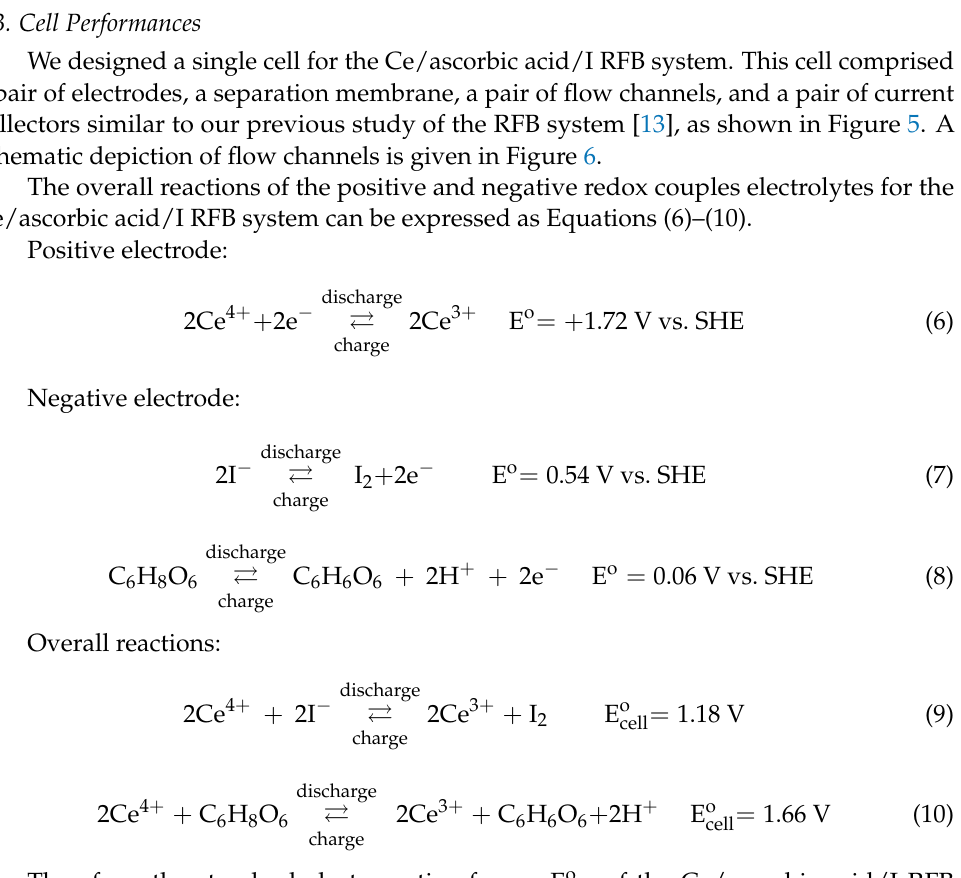
Figure 4. Cyclic voltammograms of I 2 /ascorbic acid/H 2 SO 4 active electrolyte at a concentration ratio of 1.0/0.18/2.0 M for 10 cycles at a scanning rate of 10 mV/s.